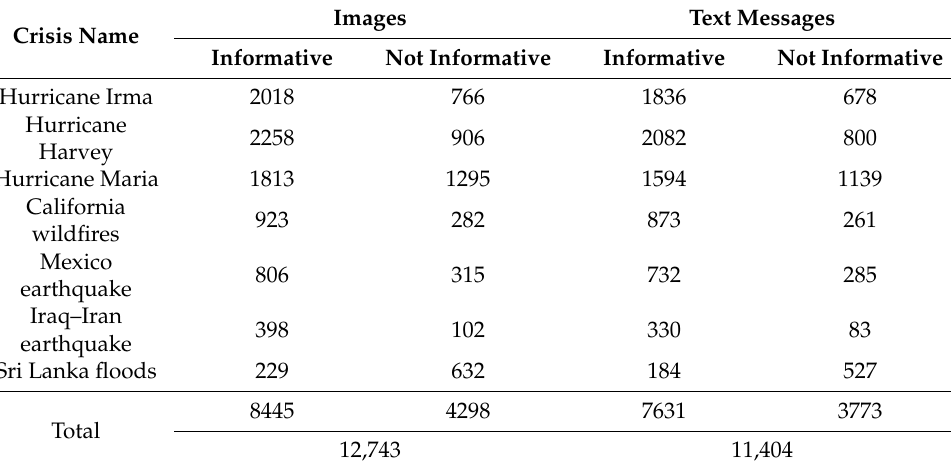
Table 2. The dataset division according to Task 1.